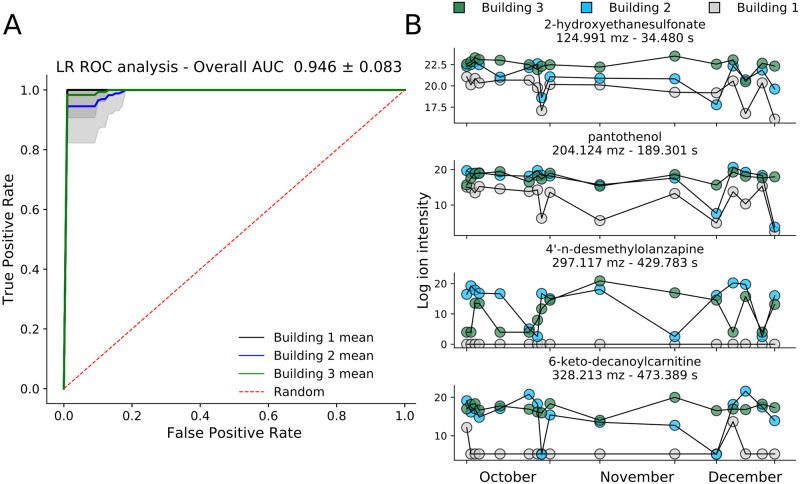
Single-day feature profiles allow accurate building classification and uncover features with building-specific fTDs.(A) ROC-AUC plot (true positive versus false positive rate) for the three one-versus-the-rest building comparisons, using individual days as data points with associated ion intensities as features. AUC plots and scores come from 50x repeated model training on randomized train-test data splits. (B) Putative identification (level 2) and log ion intensity time courses of four select, high-importance metabolites that contribute to model performance.